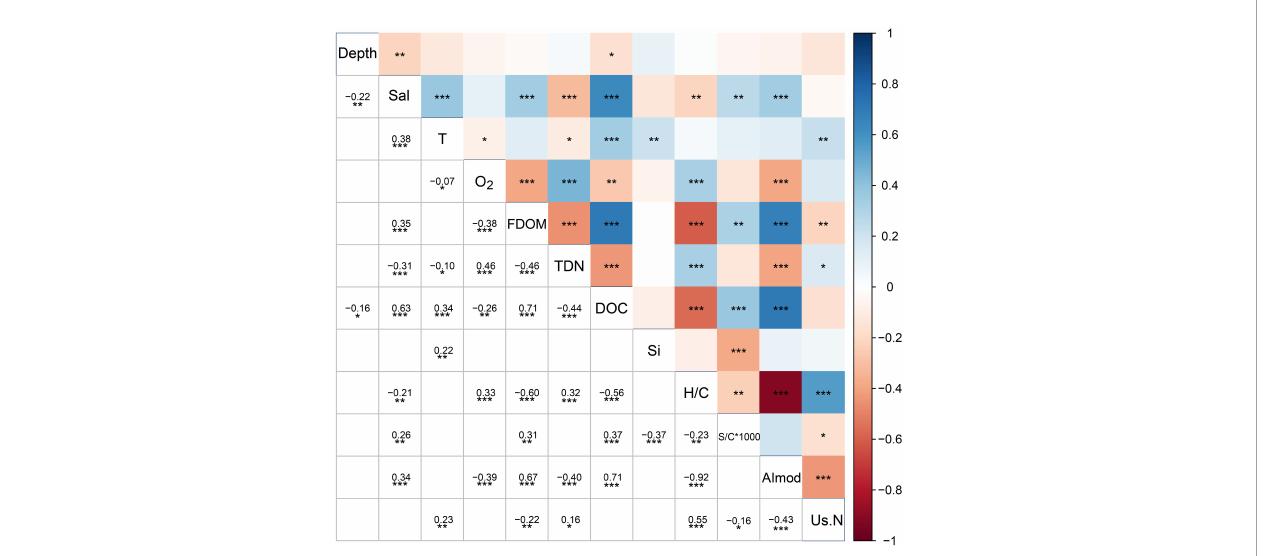
FIGURE 6 Spearman correlation between physicochemical parameters and DOM from intertidal springs across campaigns (p < 0.05, n=174). The red color represents negative correlations and the blue color represents positive correlations, and the color shades are representative of the correlation coef fi cient (Spearman ’ s r ). Asterisks indicate signi fi cance of correlation at the <0.05 (*), <0.01 (**) and <0.001 (***) levels. Us.N indicate unsaturated compounds with nitrogen. S/C*1000 is the molecular sulfur-to-carbon ratio multiplied by